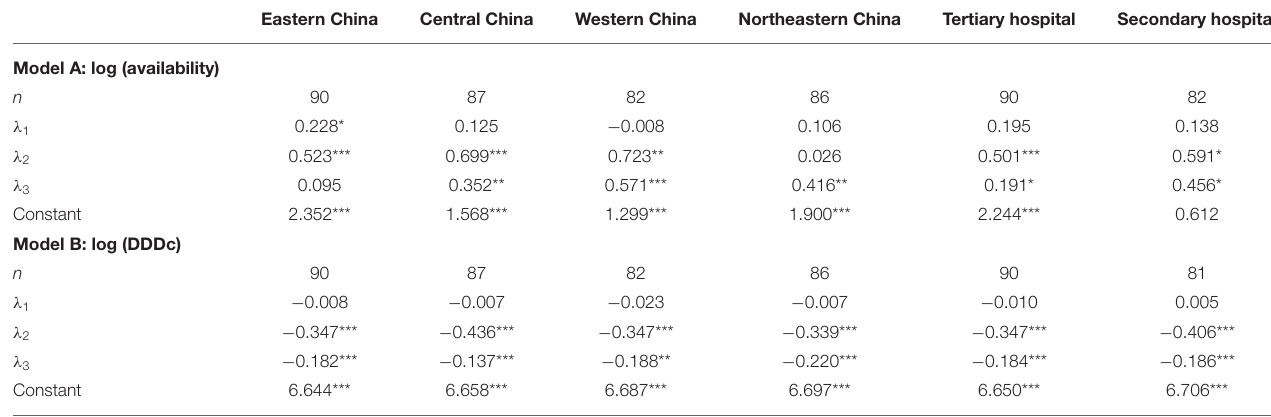
TABLE 4 | Growth curve model estimates of yearly availability and DDDc stratified by region and hospital level